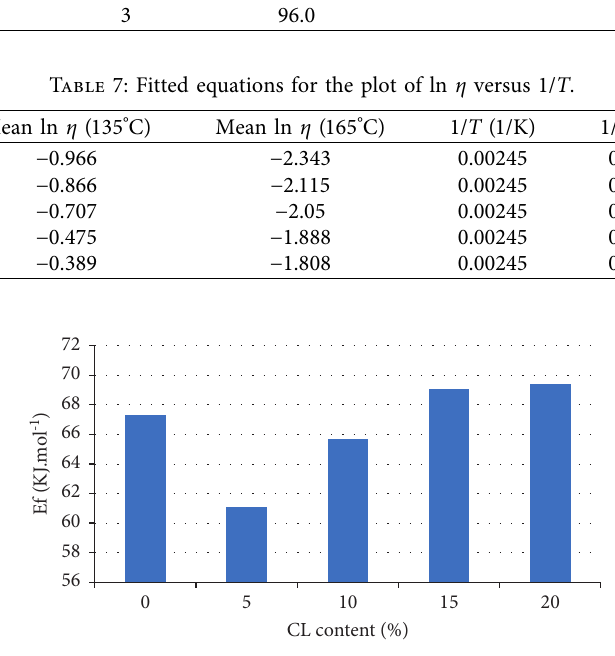
Figure 6: The activation energy of the asphalt binder containing different percentages of